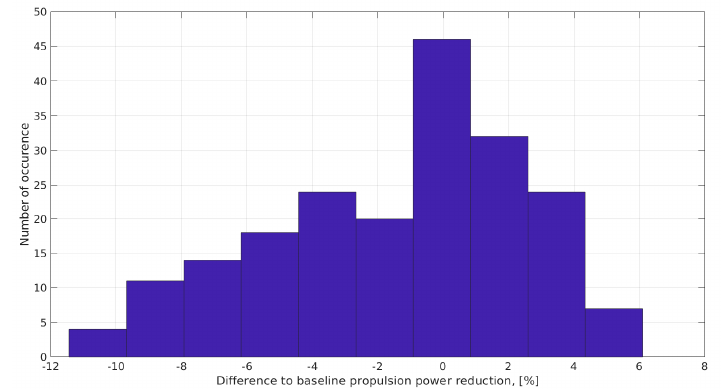
Figure 12. Results of the variation study with the two-rotor ship.